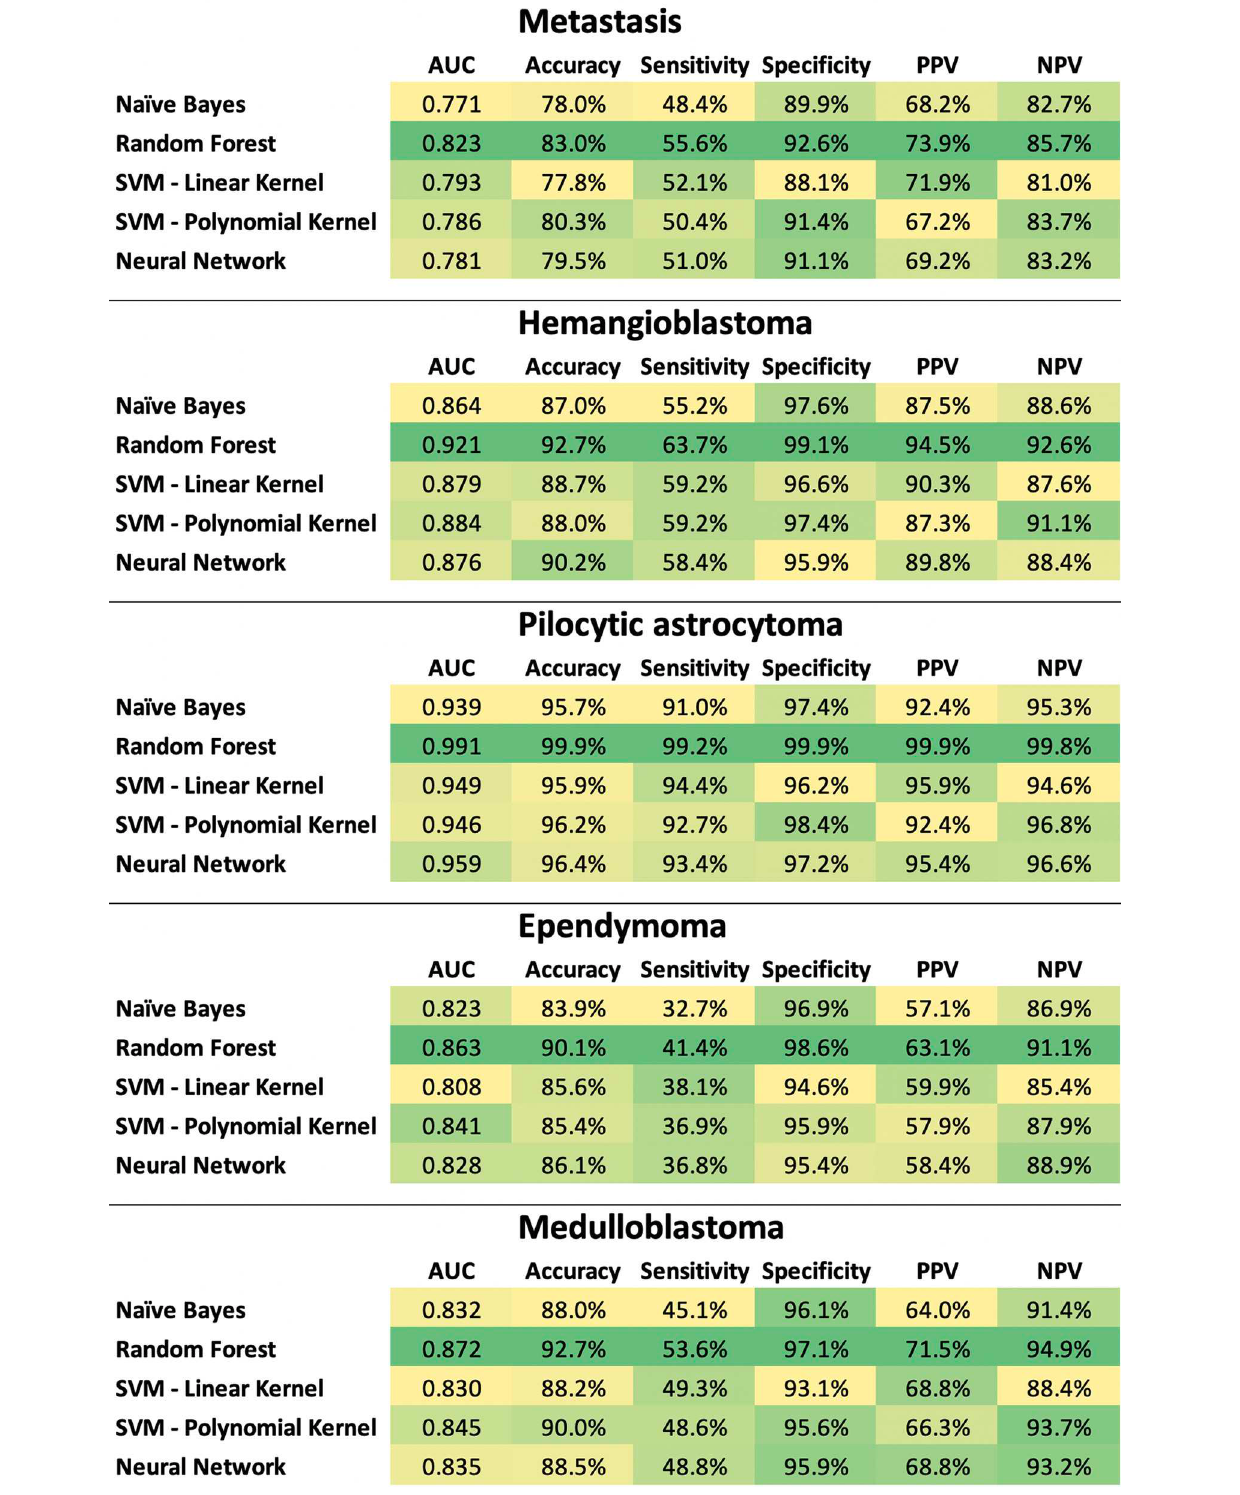
Frontiers in Oncology |